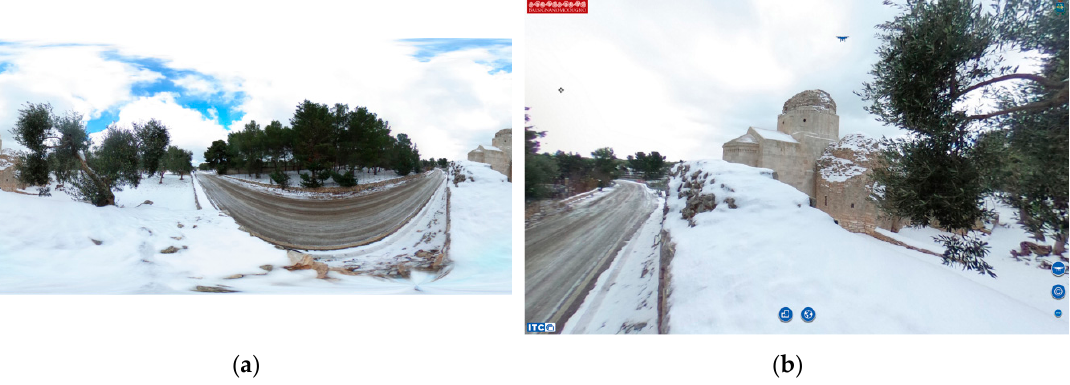
Figure 2. Exteriors of the church of San Felice (“Casale di Balsignano”): ( a ) Equirectangular image built via firmware using the two lenses Ricoh Teta S camera; ( b ) Virtual tour scene based on the aforementioned equirectangular image.